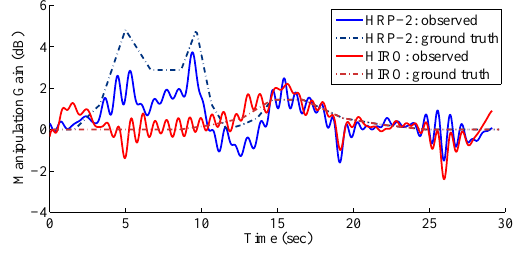
Figure 20. Observed power ratio in 2500–4000 Hz band